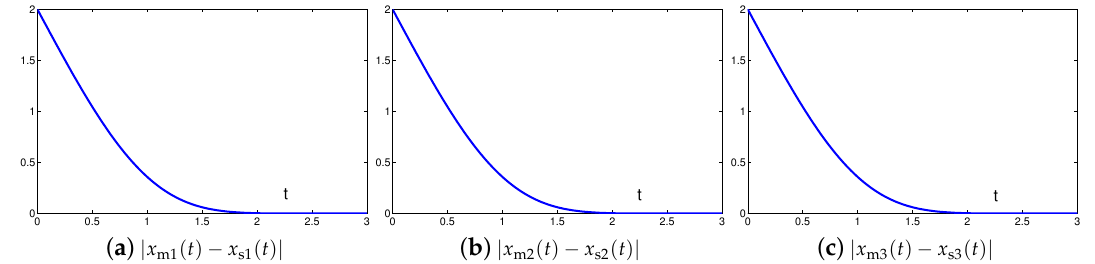
Figure 7. Absolute errors between two identical autonomous chaotic systems (27) and (28) equipped with controller (6) via the proposed SEZN approach.